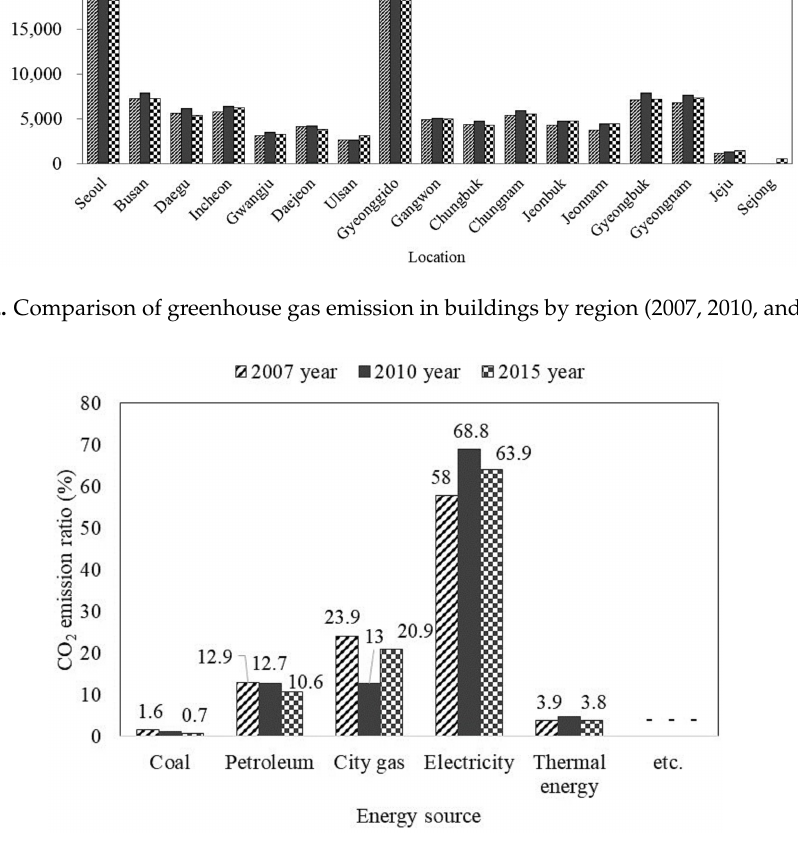
Figure 13. Comparison of greenhouse gas emission in